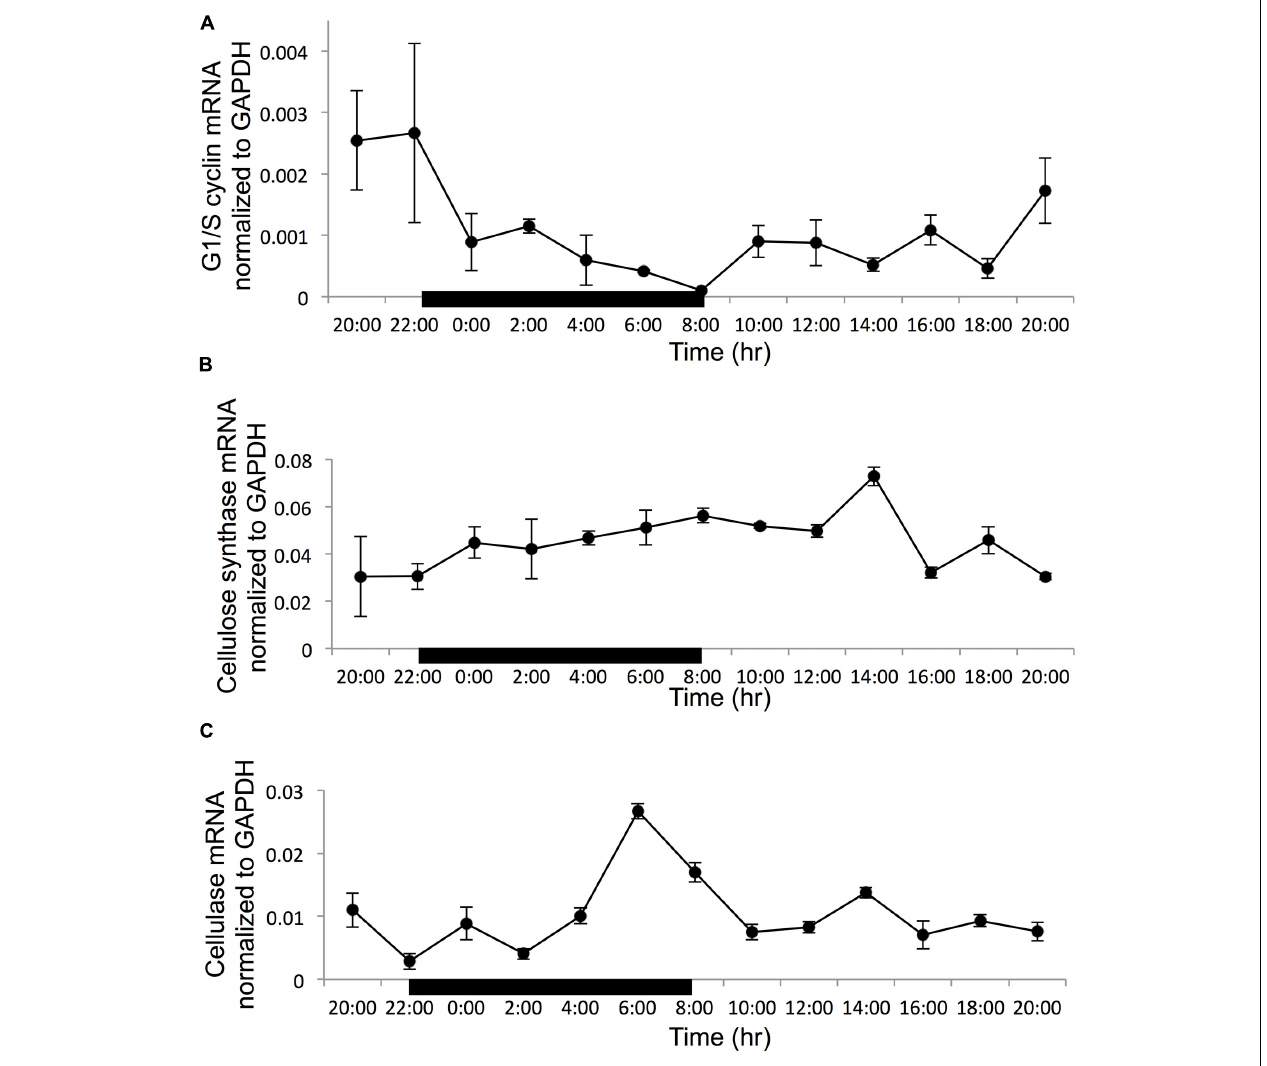
FIGURE 3 | Gene transcription dynamics of specific genes normalized to reference gene GAPDH in a cell cycle (black bar indicate dark period, other time point is light period). (A) G1/S cyclin; (B) cellulose synthase; (C) cellulose. Error bars indicate ± standard